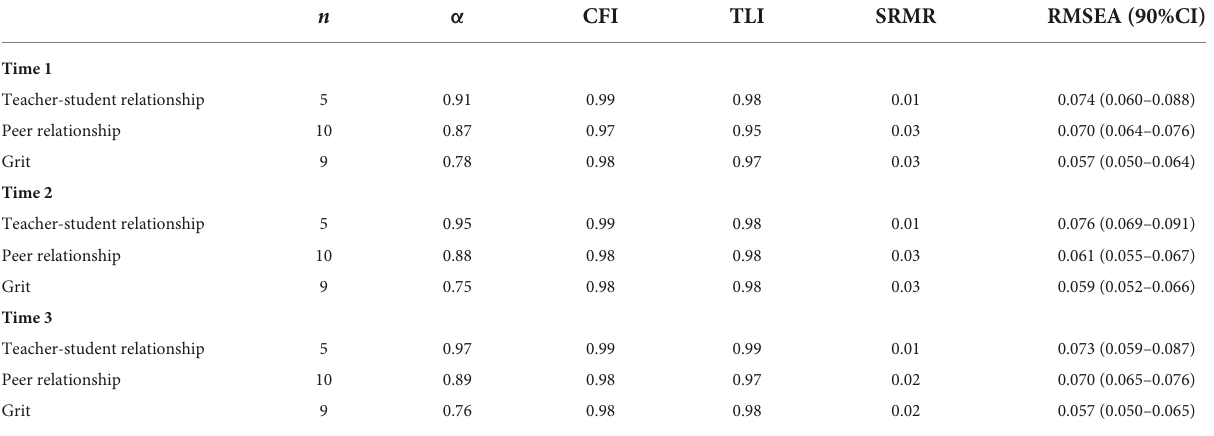
TABLE 1 The reliability coefficients and the psychometric properties of the tested